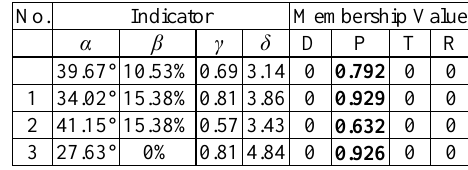
Table 6 Assessment result of parallel